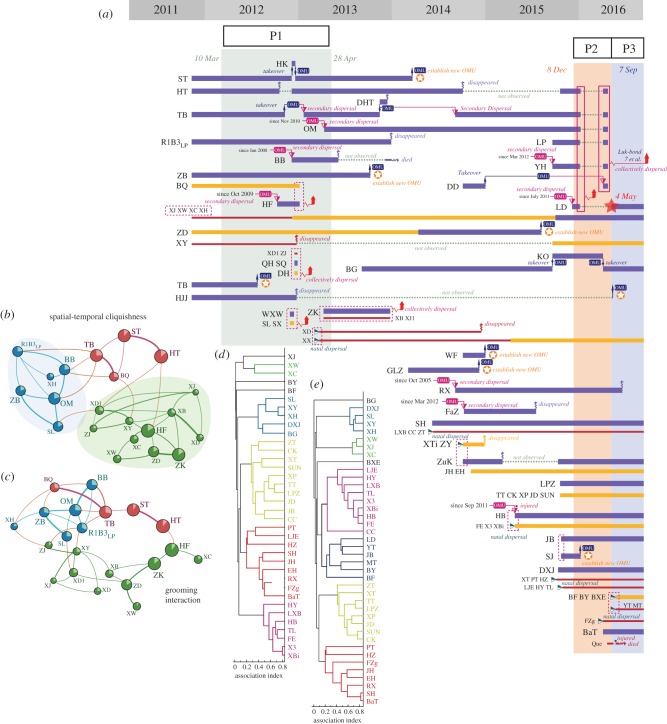
Social dynamics and individual affiliation patterns of the GNG-AMB from 2011 to 2016. (a) Each horizontal bar represents the social history of a single bachelor male of the GNG-AMB. The thickness and colour of each bar represents the age class of an individual bachelor male. Blue bars represent adults, orange bars sub-adults and red bars juveniles. Sociograms for proximity association (b) and grooming interactions (c) are based on social network analysis of the GNG-AMB. The width of each line connecting individuals denotes the half-weighted index (HWI) value (b) and the directional affiliation index (DAI) value (c) of a dyad. HWI values less than 0.17 (in b) and DAI values less than 0.19 (in c) indicate a weak relationship, which are not shown. (b) and (c) were built by the HWI matrix under Socprog v. 2.1 [29], and constructed by Netdraw v. 2.118 [45]. The area of each circle denotes values of the normalized David's scores of individuals and the angle of the sectors denotes the eigenvector centrality. Node colours represent different subgroups. Size fonts represent an individual's age class. (d) and (e) show the individual affiliation patterns of bachelor males within the AMB during different study periods. The clustering was performed by SNA among periods 2 and 3, respectively.